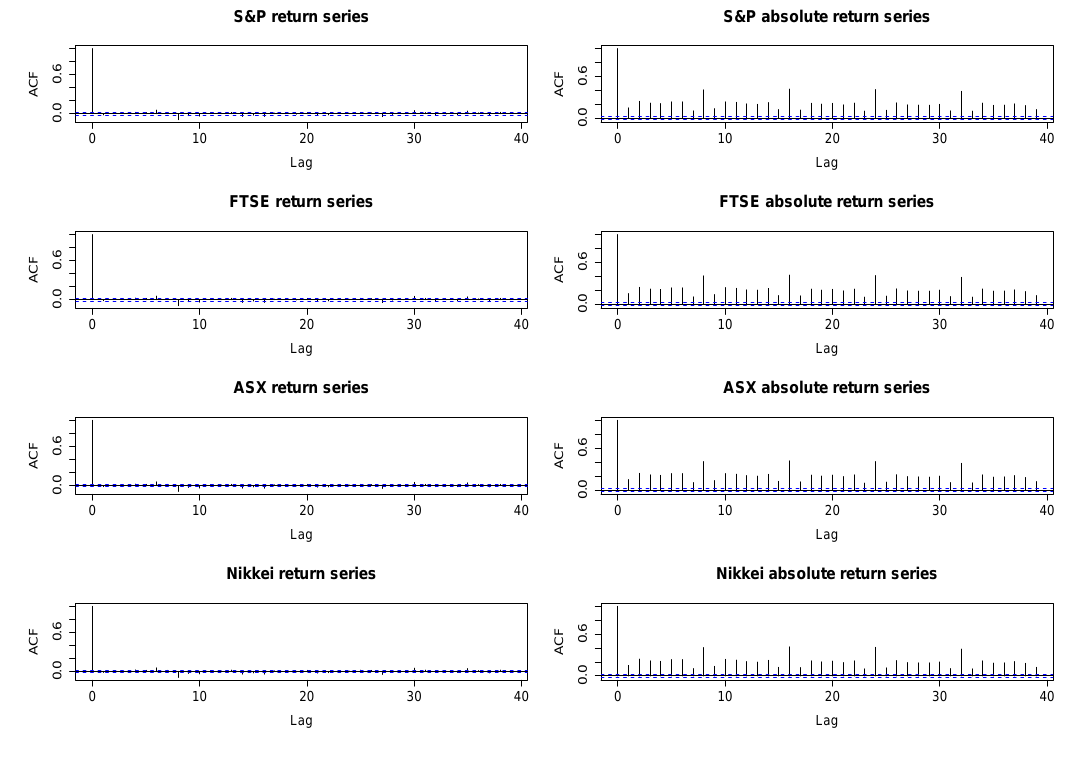
Figure 4. Autocorrelation functions for the stock indexes. Table 6. Summary statistics for the four stock index return